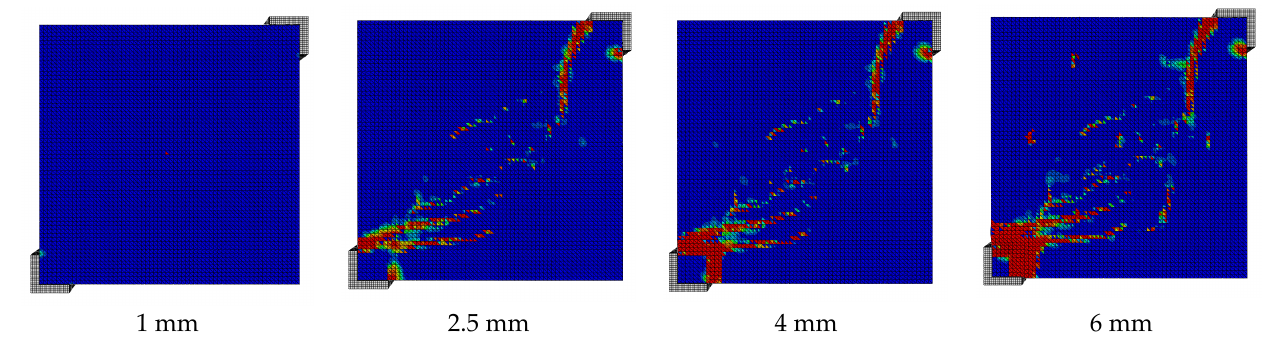
Figure 10. Damage evolution of compression.